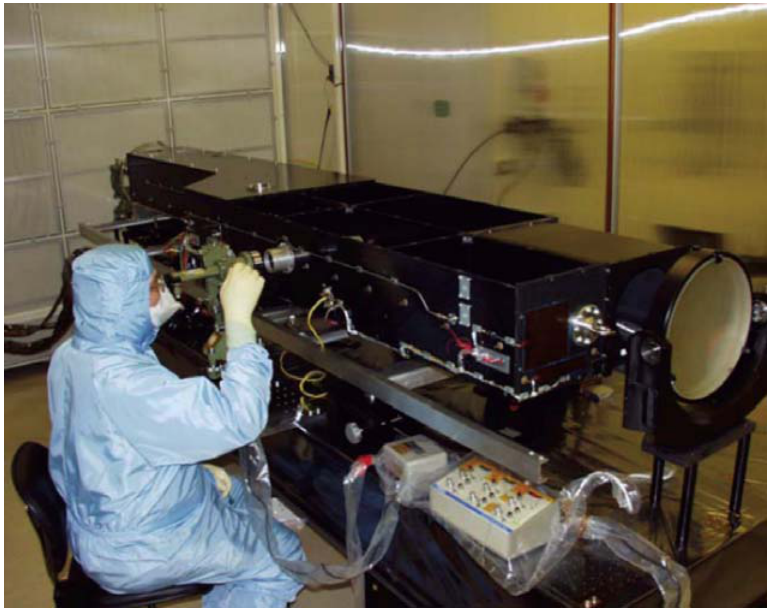
Figure 9. An NRL space scientist aligns optics on the Extreme-ultraviolet Imaging Spectrometer (EIS) at Rutherford Appleton Laboratory (RAL) in the United Kingdom. EIS component testing was carried out at NRL and on the NRL SSD beamline facility at Brookhaven National Laboratory. End-to-end calibration was performed at RAL prior to shipment to Japan for integration onto the Solar-B ( Hinode)